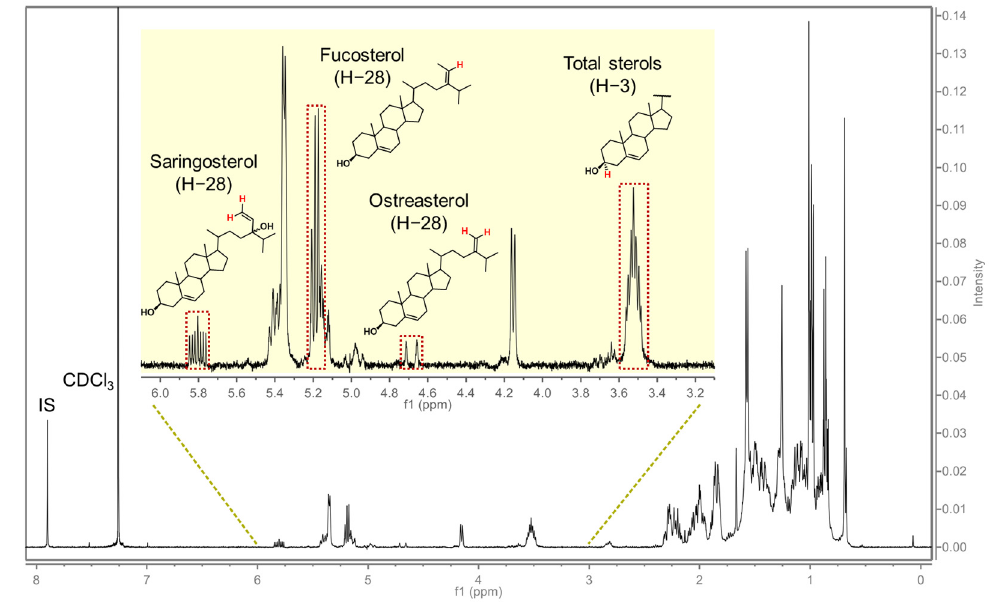
Figure 1. Typical 1 H NMR spectrum of phytosterols in brown seaweed, taking Hijiki as an example.